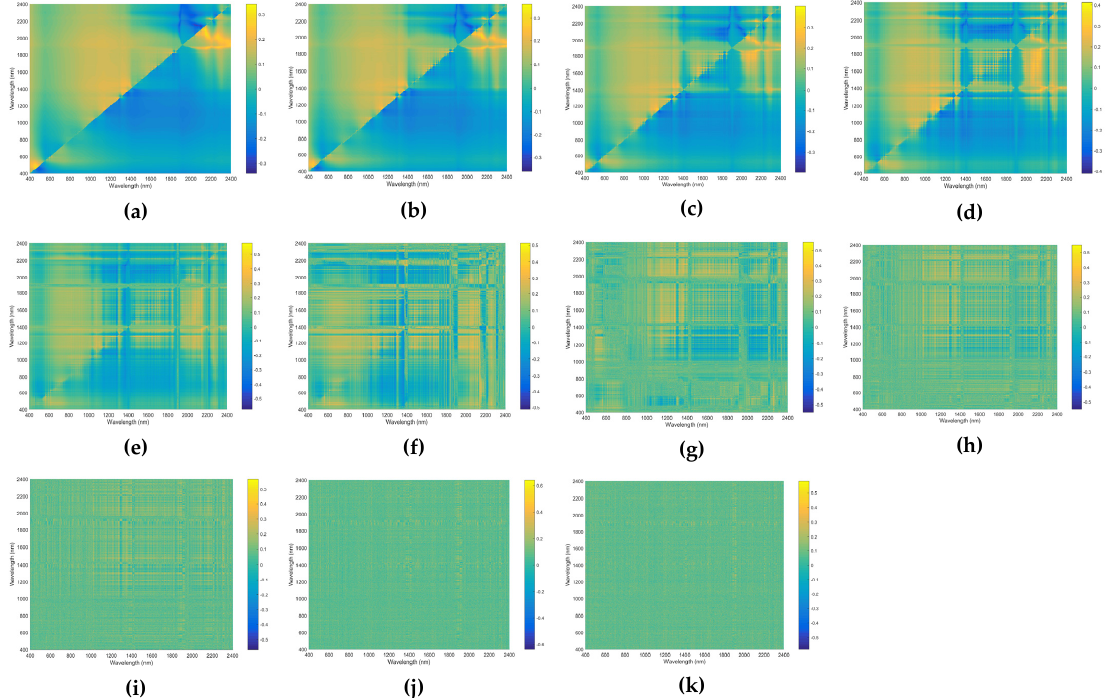
Figure A3. Correlation coefficients between soil Hg and normalized difference index of the reflectance processed by ( a ) 0-order, ( b ) 0.2-order, ( c ) 0.4-order, ( d ) 0.6-order, ( e ) 0.8-order, ( f ) 1-order, ( g ) 1.2-order, ( h ) 1.4-order, ( i ) 1.6-order, ( j ) 1.8-order, ( k )